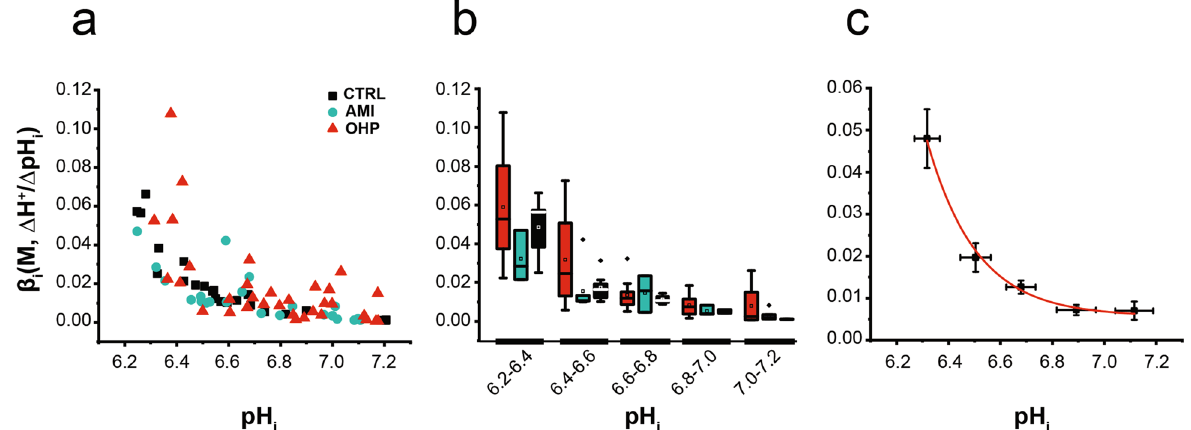
Figure 1. Intrinsic buffering power in DRG neurons. ( a ) Intrinsic buffering power (β i ) as a function of pH i . β i values were estimated, in single untreated DRG neurons or treated with OHP and AMI, from Δ pH i measured upon removal of NH 4 Cl (mM) pulses in Na + -free solution. Data were collected from 3 to 6 different cultures for each condition. ( b ) Mean (square), median (line across the box), interquartile range (box), maximum and minimum (Hyphens over and under the box) of β i values from ( a ) at five ranges of pH i for untreated (CTRL), AMI- and OHP-treated neurons. ( c ) Mean and SEM of pooled β i values from the different experimental conditions at the five ranges of pH i . Solid red line represents a single exponential decay fitting curve,